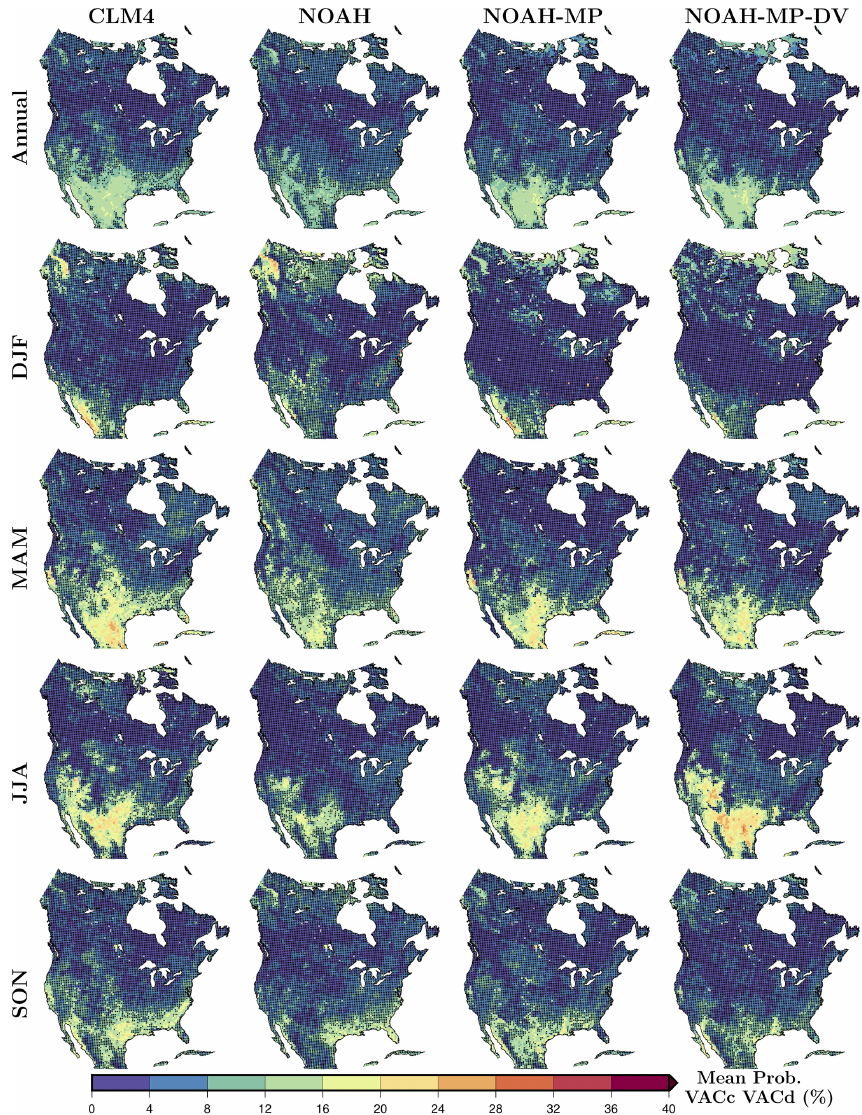
Figure 2. Mean frequency of occurrence for VAC categories associated with land control (VAC c and VAC d ) for each simulation annually and seasonally; DJF, MAM, JJA and SON. Black dots in the maps indicate VAC values lower than the 95th percentile of the randomly generated series and therefore areas with no significant